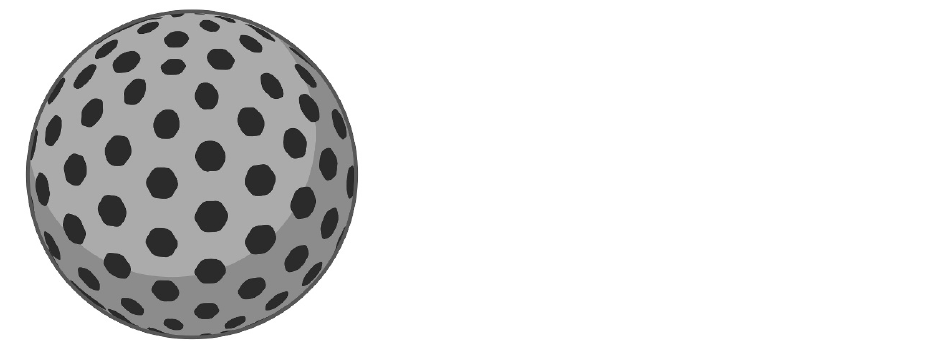
Figure 2. Mesoporous silica nanoparticle as a typical representative of DNP concept.